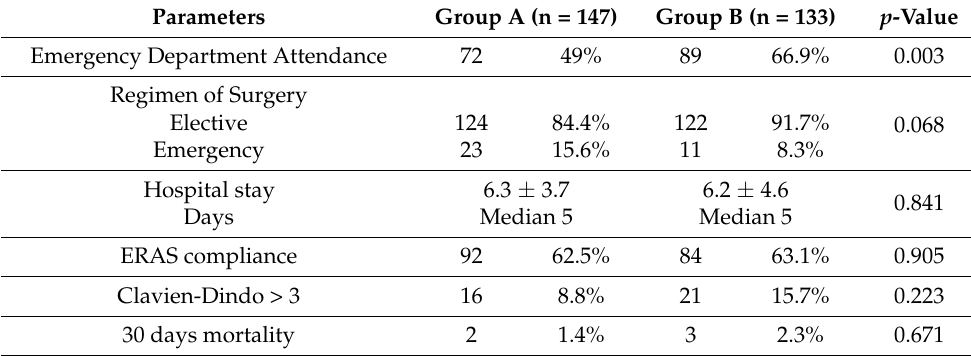
Table 5. Secondary outcomes.